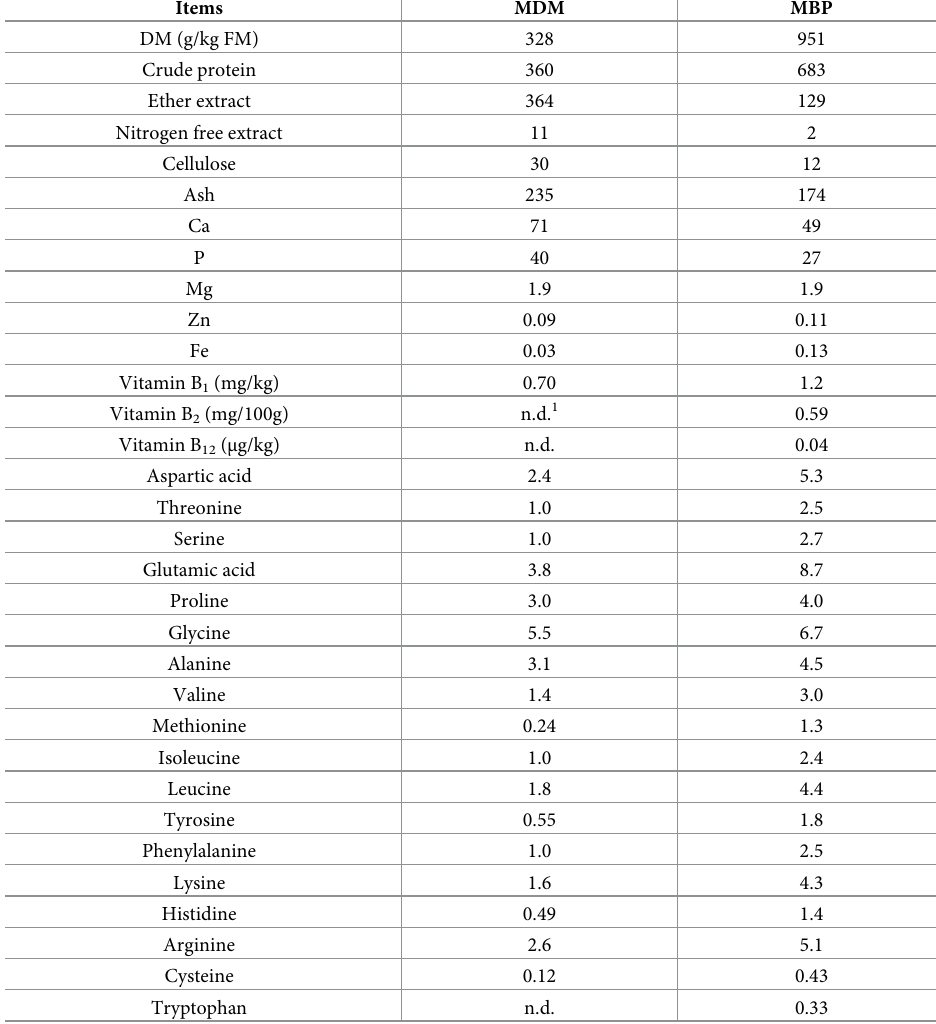
Table 1. Chemical composition (g/kg dry matter), mineral content (g/kg dry matter), vitamin content and amino acid content (g/100 g dry matter) of the two types of feed materials (FM). Items